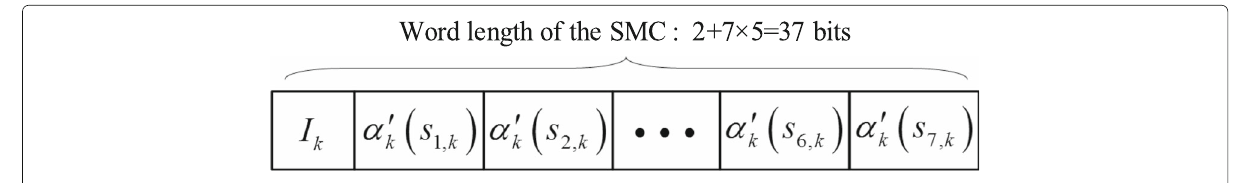
Fig. 1 Word structure of the state metrics